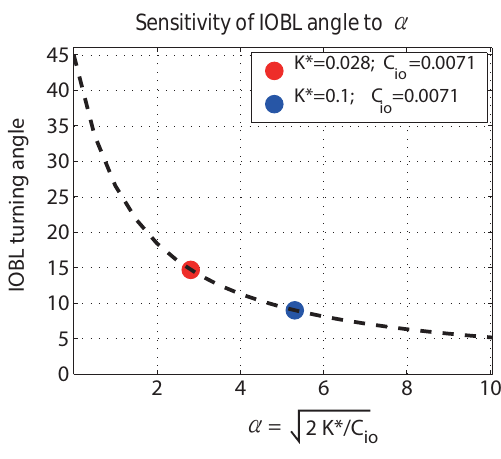
Figure 2. Sensitivity of the IOBL turning angle ( θ IOBL ) to α q /C io ), calculated from Eq. (20), which is for ϕ ∼ 1. The ( = 2 K ∗ 0 red dot corresponds to the canonical value for the vertical eddy dif- fusivity ( K ∗ o = 0.028) and the blue dot corresponds to a nominally increased value ( K ∗ o =